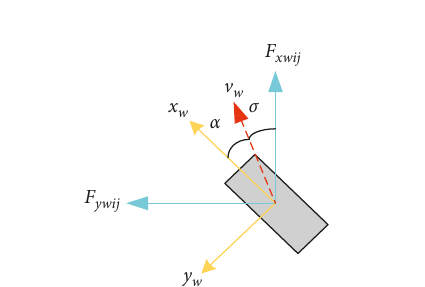
Figure 3: Tire coordinate